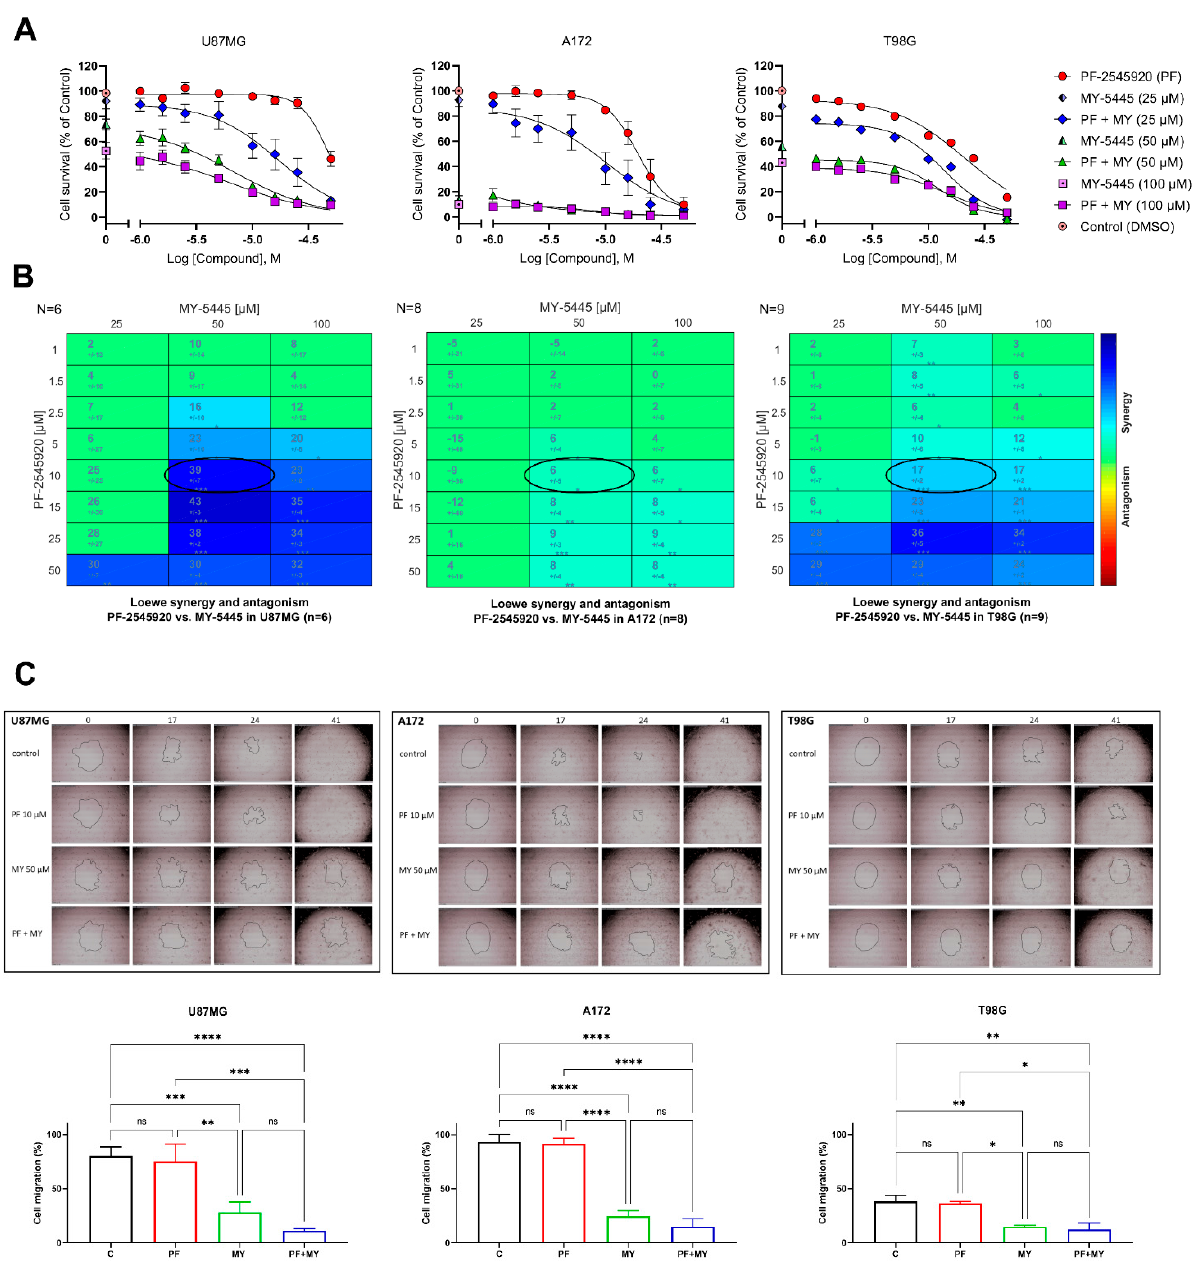
Figure 5. Synergistic suppressive action of PF-2545920 and MY-5445 on the viability and migration of glioblastoma cells. ( A ) Concentration–response relationships for the inhibitory action of PF-2545920 on the viability of U87MG, A172 and T98G cells were obtained using the CCK-8 assay in the absence or presence of MY-5445 at 25–100 µ M. ( B ) In the synergy plots, the colour indicates the degree of synergism, and the values indicate synergy scores using the Loewe model as previously described [25]. The stronger the synergy is, the darker blue is the background, and the higher is the synergy score. Asterisks indicate the significance of synergy scores obtained following a one sample t -test (* p < 0.05; ** p <0.001, *** p < 0.0001; the number of replicates (N) is shown in the left top corner of the matrix display). ( C ) Migration capability of U87MG, A172 and T98G cells was assessed from the degree of closure of the initial cell-free gap area (outlined by a contour line in the centre of each image) after 24 h in culture using the Radius™ cell migration assay. C: control (vehicle); MY: 50 µ M MY-5445; PF: 10 µ M PF-2545920: PF+MY: combination treatment. Concentrations for the migration experiment were chosen from the synergy points designated by ovals in ( B ). Data are presented as the mean ± standard deviation ( n = 3). The statistical significance of differences in cell migration is indicated as follows: * p < 0.05; ** p < 0.01; *** p < 0.001; **** p < 0.0001 (post hoc Tukey’s test).